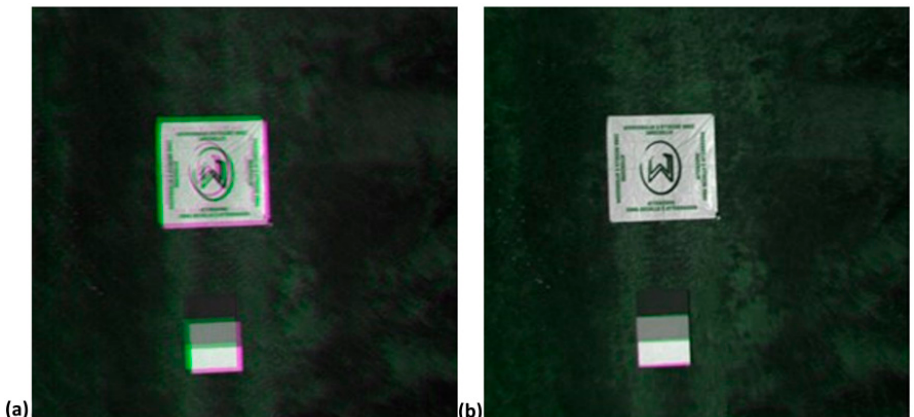
Figure 12. Example of co-registration images result: ( a ) no co-registrated bands and ( b ) co-registrated bands.